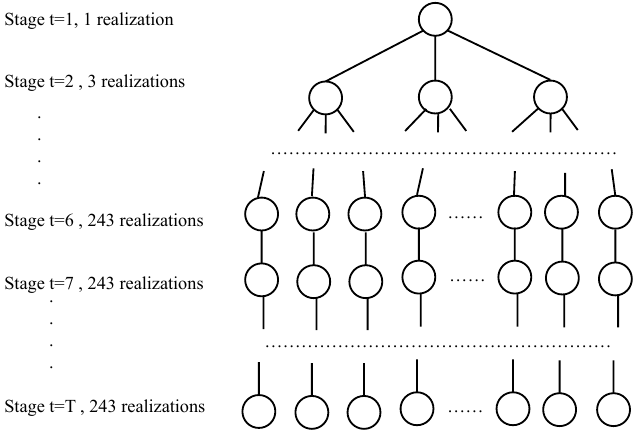
Figure 3. An approximation of the multistage stochastic